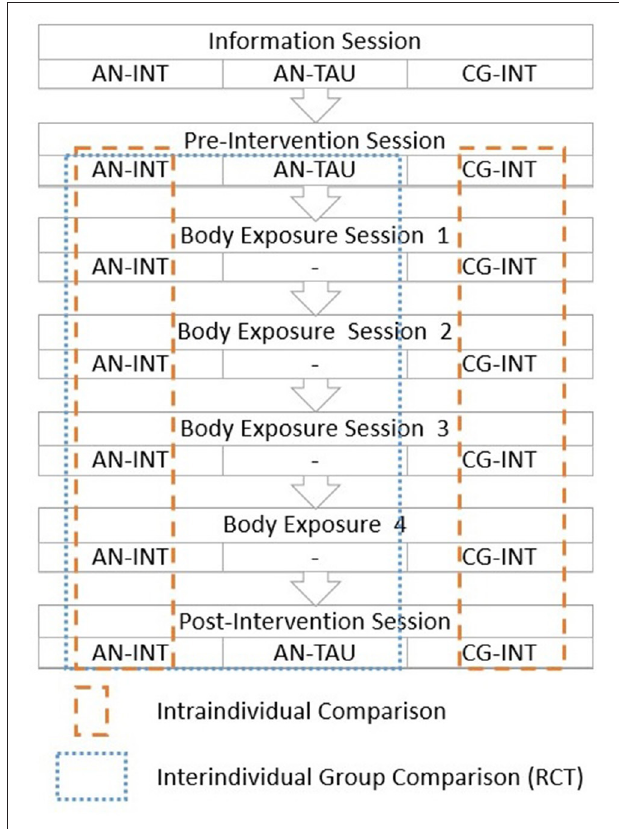
FIGURE 1 | Study Design. The figure shows the sessions which the different groups complete (AN-INT, Anorexia Nervosa Group-Intervention; AN-TAU, Anorexia Nervosa Group-Treatment As Usual; CG-INT, Body Dissatisfied Control Group-Intervention) and how the groups will subsequently be compared. Within the RCT, adolescents with AN obtaining the intervention (AN-INT) vs. treatment as usual (AN-TAU) will be compared to each other. In a transdiagnostic approach, a body-dissatisfied group of clinical control participants (CG-INT) obtaining the intervention will be compared to AN-INT